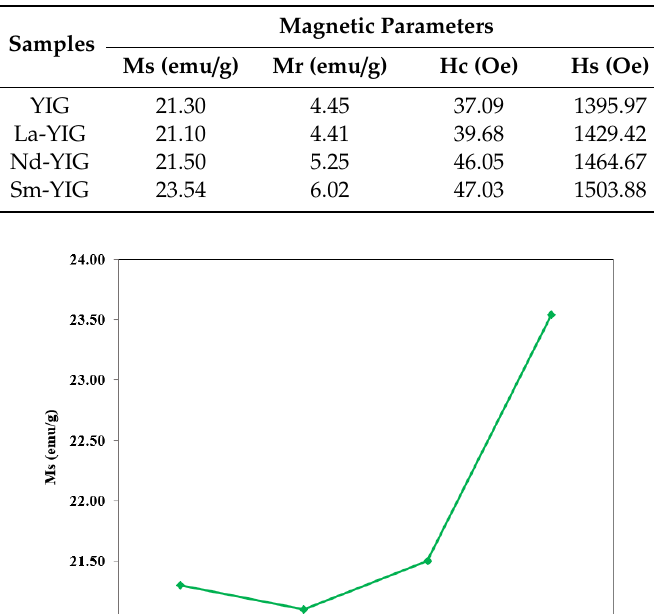
Table 3. Properties of RE-YIG nanoparticles.